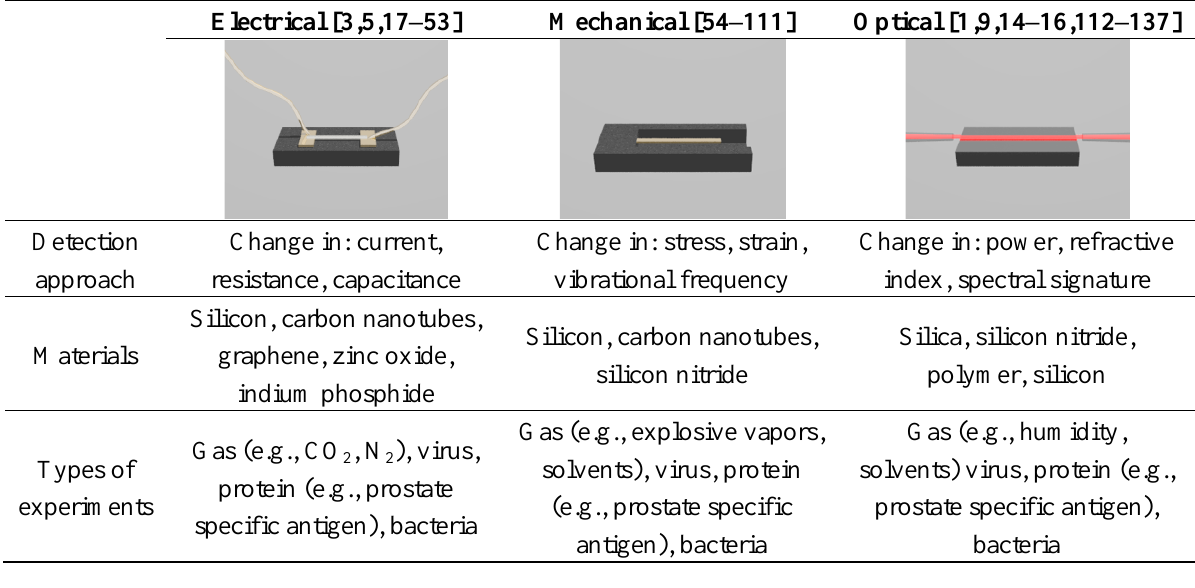
Table 1. Summary of different sensors, detection mechanism, and examples of detection. Additional details on each detection modality are found in the subsequent